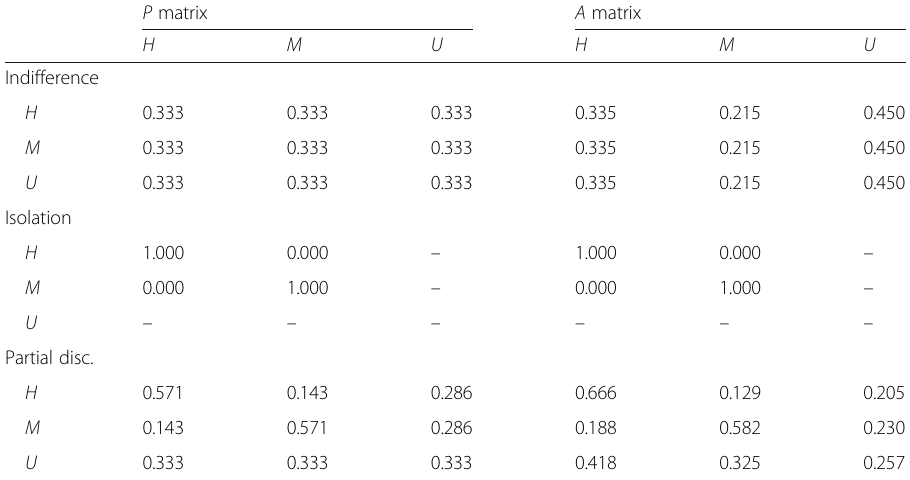
Table 2 Examples of P and A matrices for three alternative preference patterns: repeated immigration P matrix A